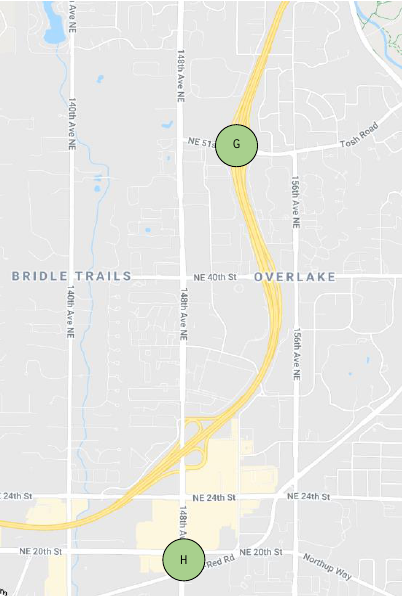
Figure 9. Road topology of the simulations reference model used for protocol